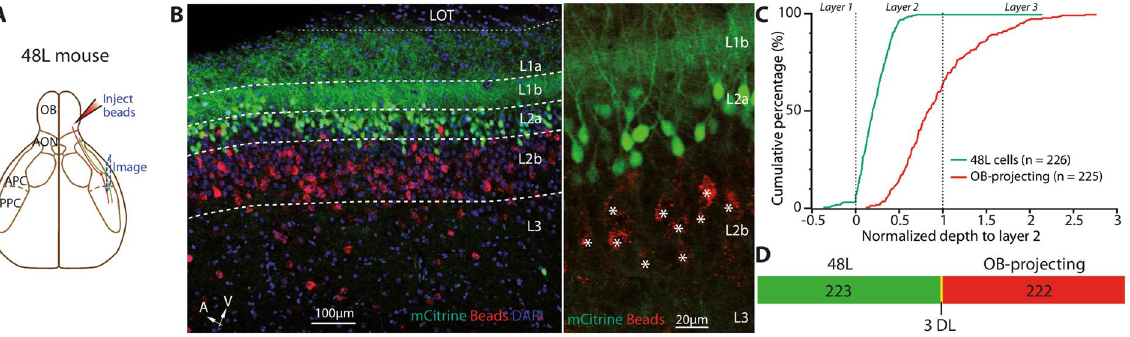
Figure 5. Genetically labeled SL cells do not send feedback projection to the OB. ( A ) Schematic representation of the injection strategy. Red Retrobeads were injected into the OB of 48L mouse. Images were taken from the APC. ( B ) Red bead injections in the OB of 48L mouse failed to labeled mCitrine + cells, indicating that the genetically tagged subset of SL cells is not projecting back to the OB (3 dually-labeled cells for 225 Retrobeads + cells and 226 mCitrine + cells, 3 sections, 2 mice). Middle and right panels are extracted from different experiments. Stars in right panels indicate Retrobeads + OB-projecting cells. Red: Retrobeads. Green: mCitrine. Blue: DAPI. ( C ) Cumulative distribution of 48L-labeled cells and Retrobead-labeled cells in the APC (n = 225 Retrobeads + cells, 226 mCitrine + cells, 3 sections, 2 mice). ( D ) Venn diagram showing the near-zero overlap of 48L cells and OB-projecting